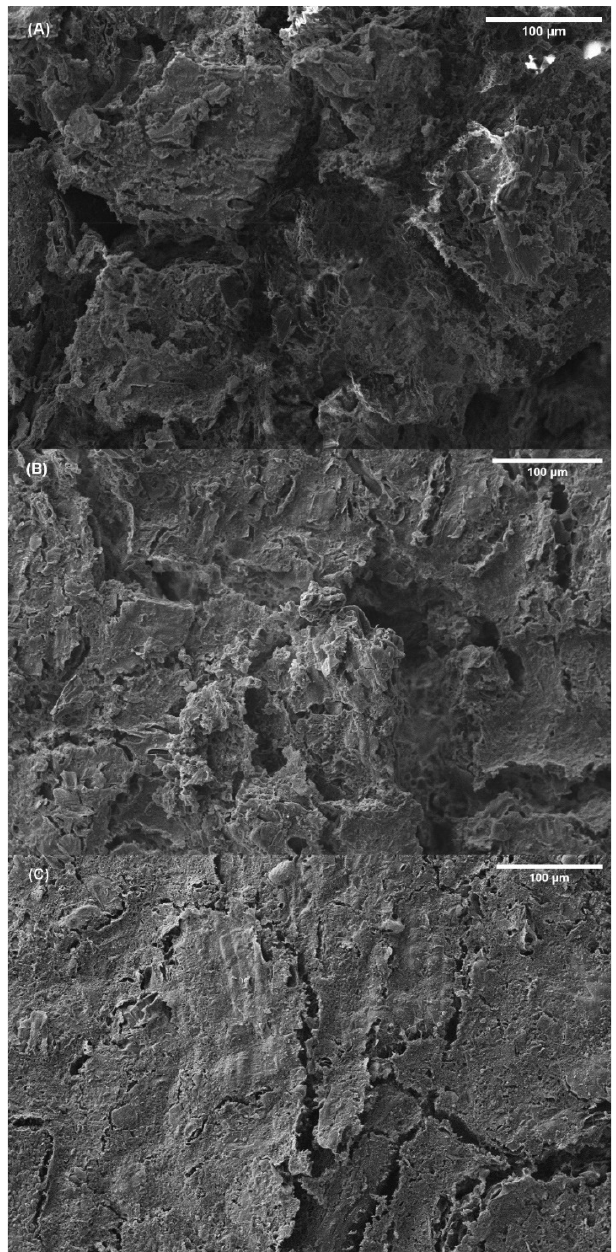
Figure 7. Scanning electron microscopy images of RO/GLY 50/50 ( A ), 60/40 ( B ) and 70/30 ( C )